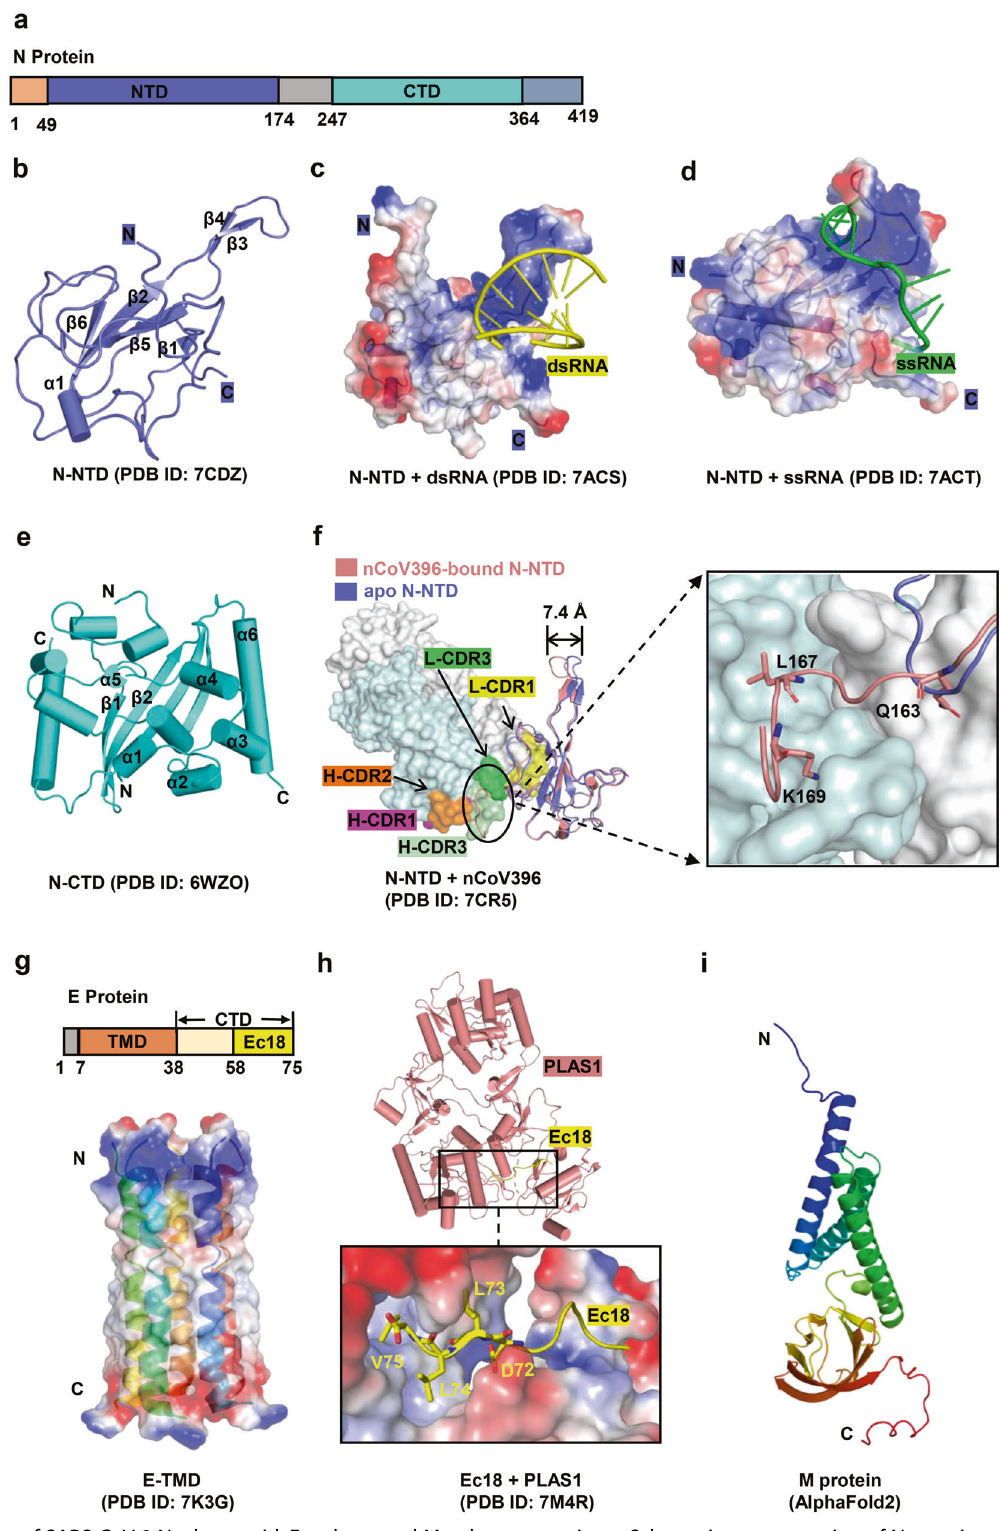
Fig. 3 Structures of SARS-CoV-2 Nucleocapsid, Envelope, and Membrane proteins. a Schematic representation of N protein organization. NTD N-terminal domain, CTD C-terminal domain. b Overall structures of N-NTD. c, d Overall structures of N-NTD in complex with ssRNA and dsRNA, respectively. The N-NTD is illustrated with electrostatic surface. e Overall structure of N-CTD. f Conformational changes between apo and nCoV396-bound N-NTD. The monoclonal antibody nCoV396 is illustrated with surface. The key residues of interaction between nCoV396 and N-NTD are shown on the right as sticks. g Overall structure of SARS-CoV-2 E protein shown in surface and cartoon. TMD transmembrane domain, CTD C-terminal domain, Ec18 residues 58 – 75 of E-CTD. h Structure of the C-terminus of E protein (Ec18) in complex with human cell junction protein PLAS1. The Ec18 is shown in yellow. i Predicted structure of M protein using alphafold 2